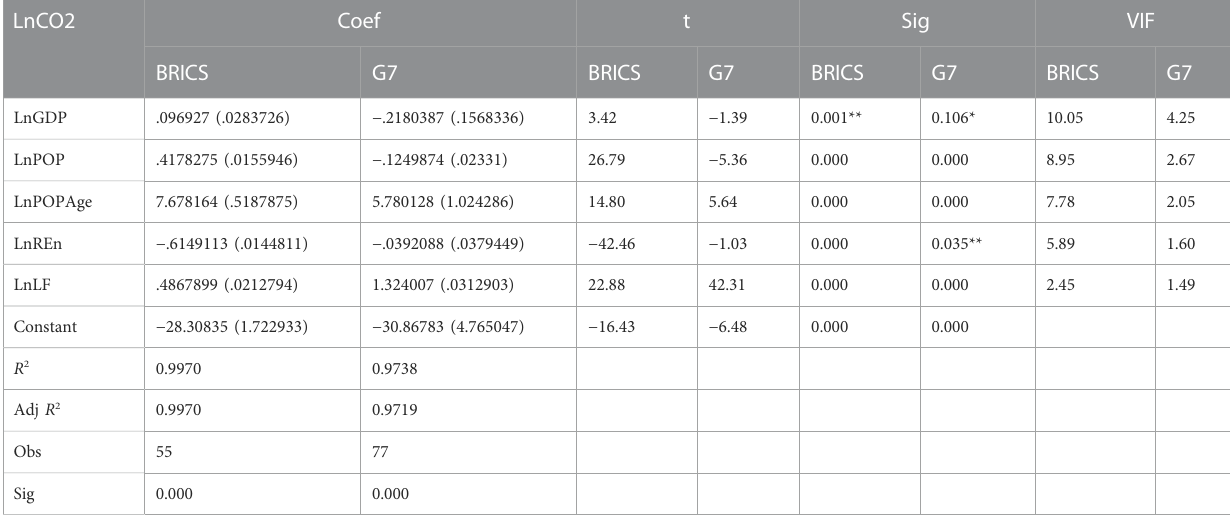
TABLE 5 OLS regression results of different impact factors on sustainable development ef fi ciency.